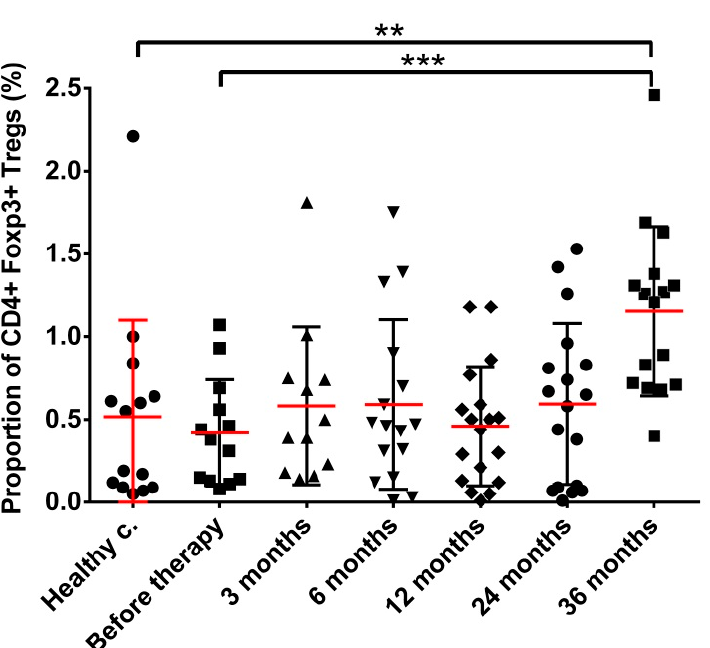
Figure 2. The proportion of Treg cells increases 36 months after radiation source implantation. Blood collection, processing and immune phenotyping were carried out as described in Materials and methods at the indicated time points relative to brachytherapy. n (healthy controls) = 14, n (cancer patients) = 12–18. Significant differences were indicated with ** ( p < 0.01) and *** ( p < 0.001). Next, we investigated two activation markers on CD4+ T cells, with their expression indicating the acquisition of immune inhibitory (CTLA4) [34,35] or immune tolerant, ex- hausted (PD1) phenotypes [36]. The fraction of CD4+ T cells expressing CTLA4 in cancer patients before seed implantation (3.01% mean with 1.38–4.63% 95% CI) was slightly higher but not significantly different from healthy controls (2.24% mean with 1.27–3.22% 95% CI), and a mild decrease was noticed after treatment, reaching significantly lower CTLA4+ T cell fractions 36 months after implantation (1.32% mean with 0.95–1.69% 95% CI) (Figure 3A). This was due to changes in the fraction of CTLA4 expressing Teff cells since this cell sub- population decreased significantly at late time points after seed implantation (24 months: 1.25% mean with 0.96–1.54% 95% CI and 36 months: 0.71% mean with 0.49–0.93% 95% CI) compared to both healthy controls (1.96% mean with 1.02–2.91% 95% CI) and prostate can- cer patients before seed implantation (2.53% mean with 1.09–3.96% 95% CI) (Figure 3B). No significant changes were detected in the amount of CTLA4+ cells within the CD4+Foxp3+ lymphocytes (Figure 3C). On the other hand, the analysis of the distribution of Foxp3+ and Foxp3 − cells within the CTLA4+ CD4+ lymphocytes showed that the fraction of Foxp3+ cells was 1.68-fold higher in prostate cancer patients before seed implantation compared to healthy controls (20.15% mean with 10.84–29.46% 95% CI in cancer patients before RT, 12% mean with 4.98–19.02% 95% CI in healthy controls), and this shift towards Foxp3+ cells continued to increase during the 36 months follow-up (33.91% mean with 24.97–42.85% 95% CI and 40.96% mean with 18.28–63.64% 95% CI in prostate cancer patients 24 months and 36 months after seed implantation, respectively) (Figure 3D). Moreover, the level of CTLA-4 expression on Foxp3+CD4+ Tregs (as evaluated by median fluorescence intensity) progressively increased in cancer patients after the initiation of radiotherapy, reaching significantly higher levels 24 and 36 months after seed implantation compared to both healthy controls and cancer patients before treatment (Figure